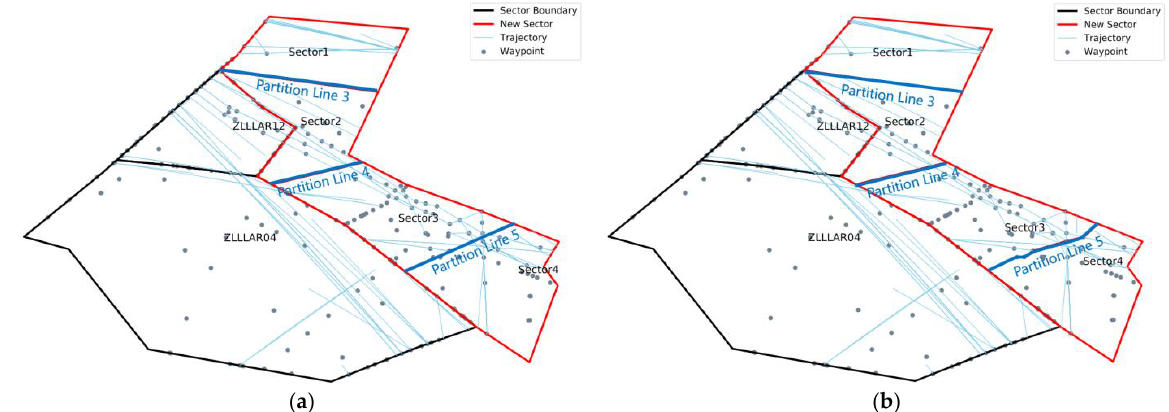
Figure 12. ( a ) 12:00 – 13:59 After one-stage; ( b ) 12:00 – 13:59 After two-stage.